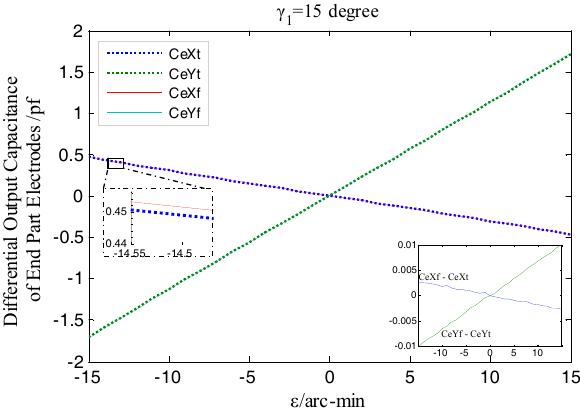
Figure 16. Simulation and theoretical results comparison of end part differential output capacitance. According to Equation (23) and (24), the yaw angle of the rotor can be derived as: